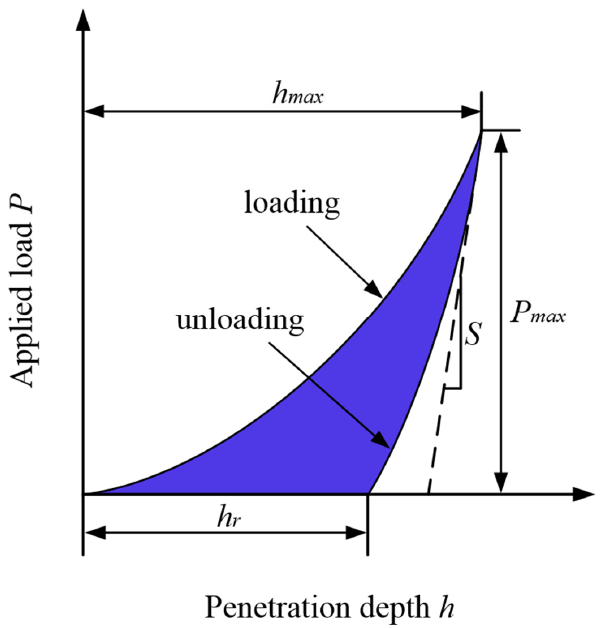
Figure 9. Typical P ‐ h curve under the thin film/substrate model.